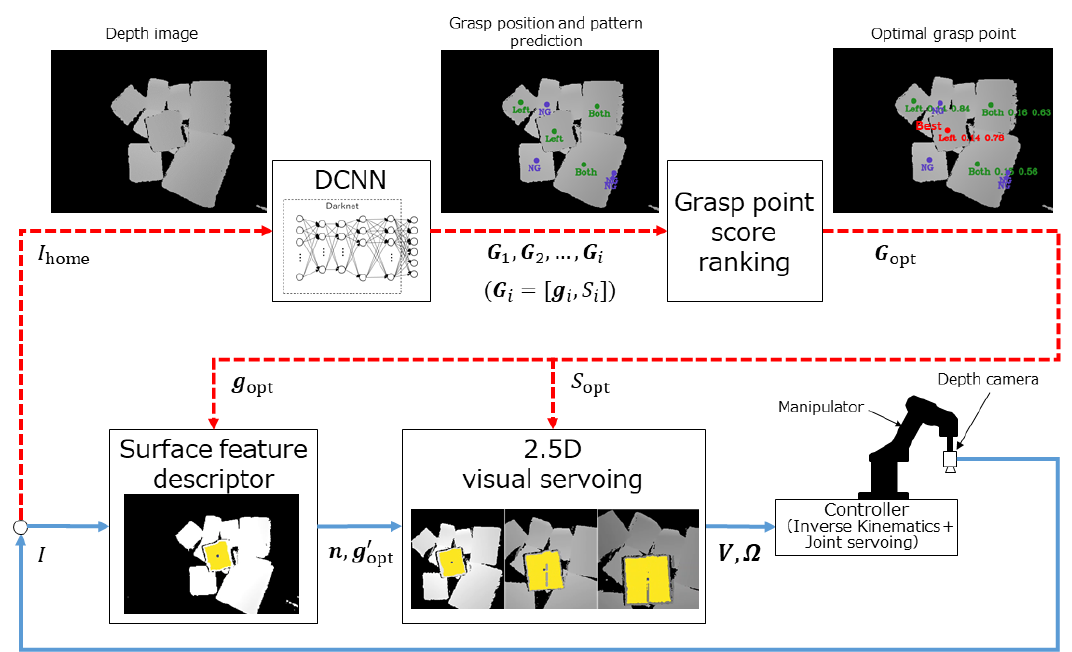
Figure 2. System diagram. The red dashed lines indicate the loop for grasp planning for textureless planar-faced objects by a deep convolutional neural network (DCNN) model at the robot’s home position. The blue solid lines indicate the visual guided robot control loop. Both loops only use depth images. I is the depth image, and I home is the depth image captured at the robot’s home position. G i is the i th predicted grasp point, defined as the set of grasp point position g and grasp pattern S . G opt is the optimal grasp point among all predicted points, and g opt and S opt indicate its corresponding position and grasp pattern, respectively. n and g (cid:48) opt are respectively the surface normal and refined center position, namely the surface feature. V and Ω are respectively the reference translational and rotational velocity of the suction